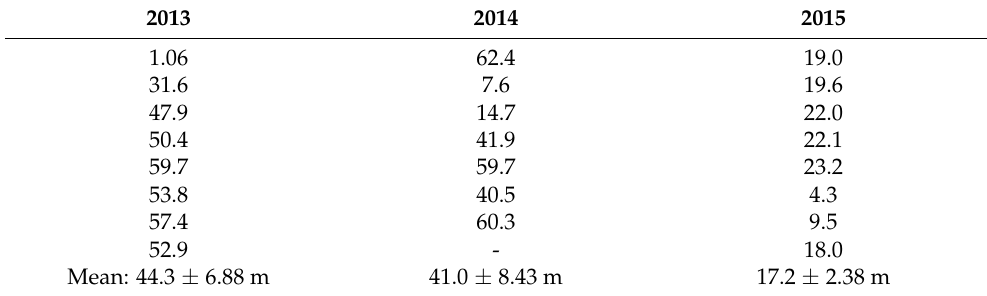
Figure 2. Photo of Gas House: nest locations shown in red, exclusion fence in yellow. Table 3. Distance (m) between nest sites and the closest entrance to the Susquehanna River for Northern Map Turtles at Port Deposit from 2013–2015. Means shown ± 1 SE in last row. There were significant differences among the three years, with 2015 having the shortest distances from the water (Kruskal–Wallis test = 6.35, p = 0.04).